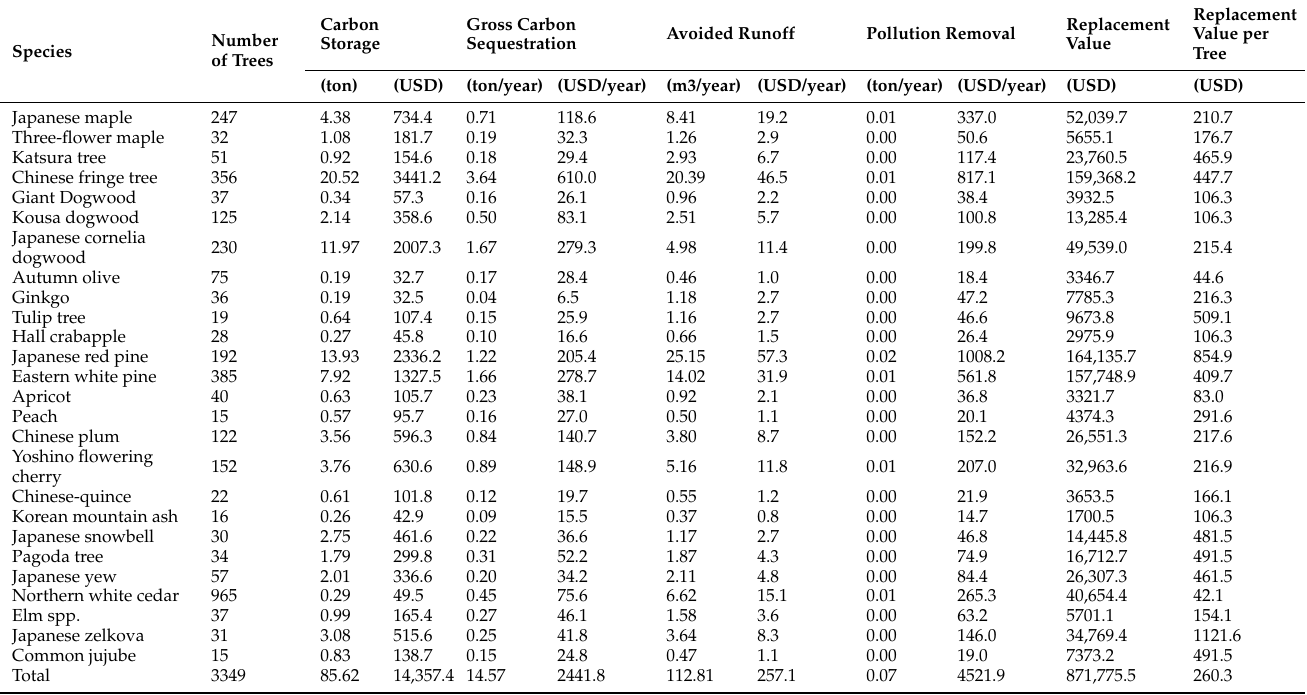
Table A2. Benefits summary of trees by